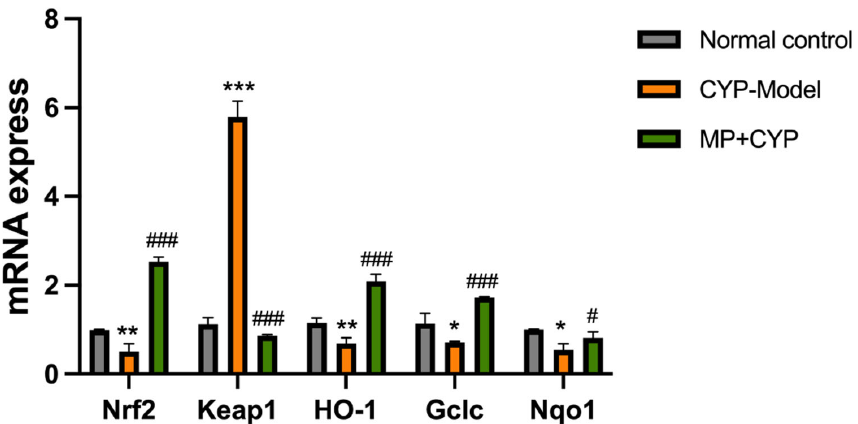
Figure 14. Effect of Maca polysaccharide on mRNA of Keap1 ‐ Nrf2 signaling in CYP ‐ treated mice ( n = 8). * p < 0.05, ** p < 0.01, *** p < 0.0001 compared with Normal Control group; # p < 0.05, ### p < 0.0001 compared with CYP Model group. Data are expressed as means ± SEM.